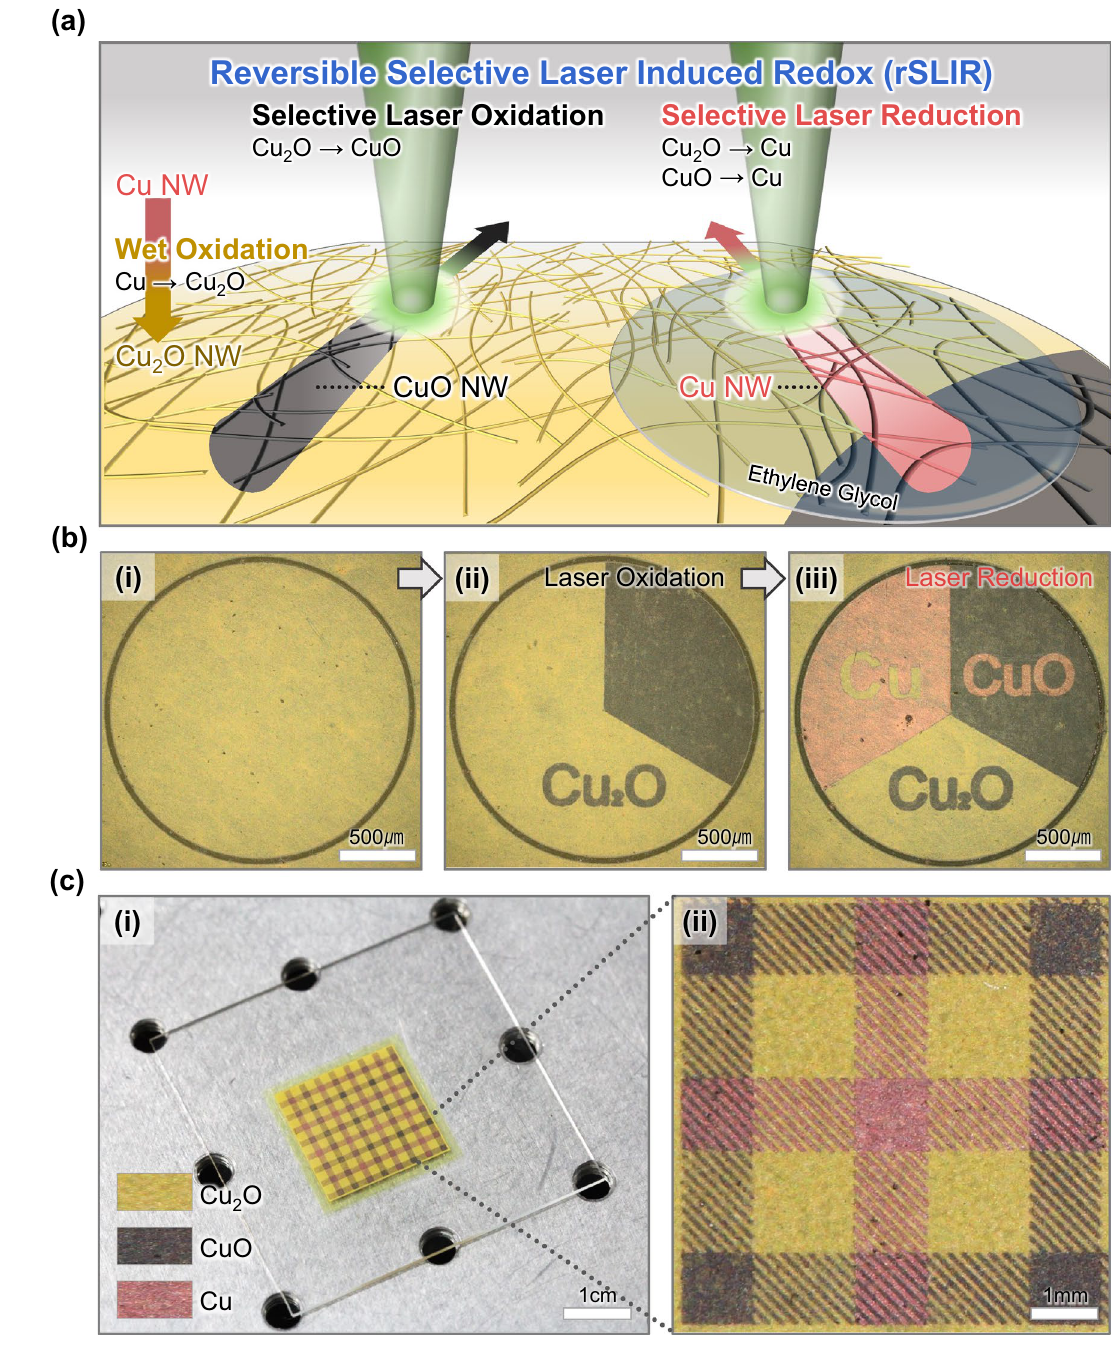
Fig. 1 a Schematic of reversible selective laser-induced redox (rSLIR) for the monolithic CuNW, Cu 2 ONW, and CuONW network. b Optical microscopy image depicting the flow of rSLIR for i Cu 2 ONW ii Cu 2 O, and CuO patterns obtained after laser oxidation with 25 mW of power and a 1 mm s −1 scanning speed. iii Cu, Cu 2 O, CuO pattern obtained after laser reduction (scale bar: 500 µm). c Optical image of the sophisti- cated three-coloration pattern, i tartan check pattern (scale bar: 1 cm), ii magnified image of the tartan check pattern. The black CuONW and the red CuNW patterns were fabricated under ten cycles of the hatch scan at 125 mW power and 10 mm s −1 scan speed, and one cycle of the hatch scan at 125 mW power and 10 mm s −1 scan speed, respectively (scale bar: 1